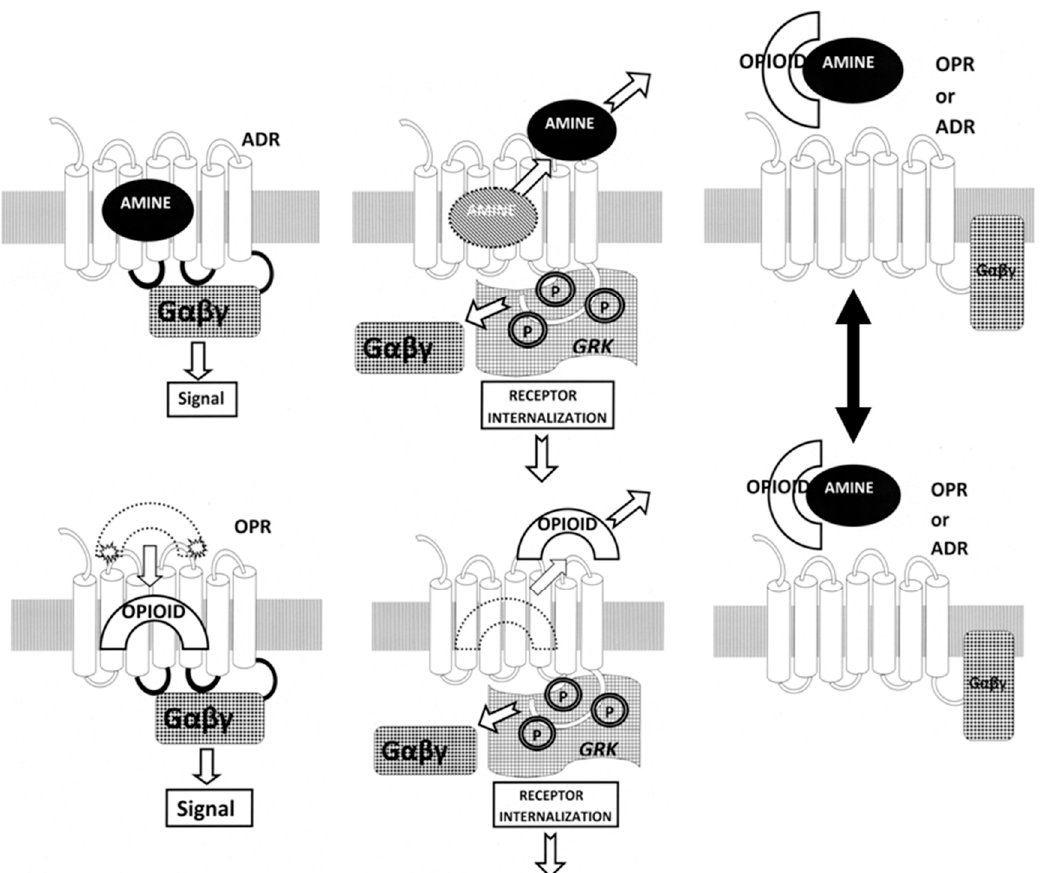
Figure 12. Schematic diagram of normal adrenergic receptor (ADR) and opioid receptor (OPR) function. Top Right: An adrenergic compound such as epinephrine binds to the ADR high-affinity site, initiating G-protein coupling (G αβγ ) to the intracellular loops of the receptor. Top Center: Binding is followed a short time later by the release of the ligand, phosphorylation (P) of the receptor by receptor kinases (GRK), and receptor inactivation and internalization. Bottom Right and Center: The same process characterizes opioid binding to OPR. Right Top and Bottom: Presence of both opioids and aminergic compounds activates both sets of receptors and initiates heterodimerization of the receptors. Notably, this receptor heterodimerization is mirrored by heterodimerization of the opioid and aminergic compounds as well, as demonstrated in this paper and in [78].